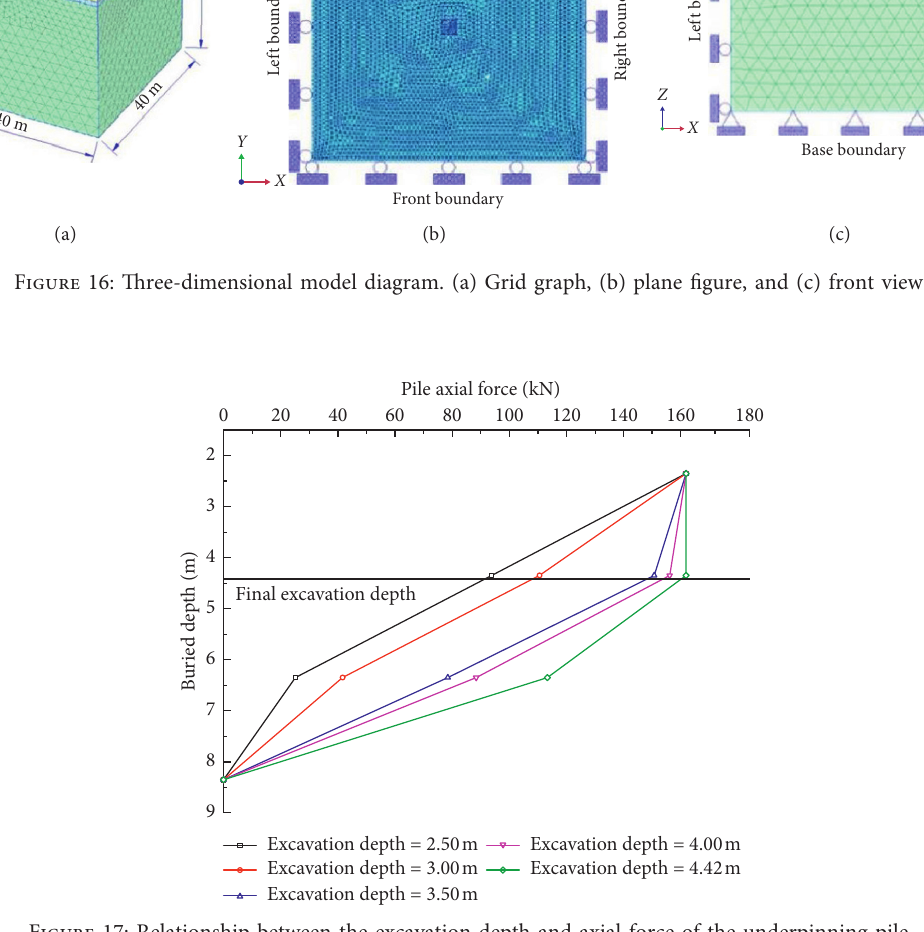
Figure 17: Relationship between the excavation depth and axial force of the underpinning